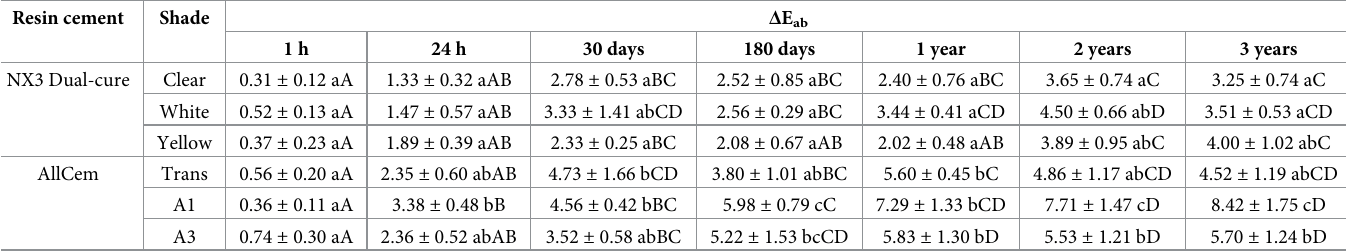
In each row, values followed by the same capital letters are statistically similar (p > 0.05). In each column, values followed by the same lowercase letters are statistically similar (p >